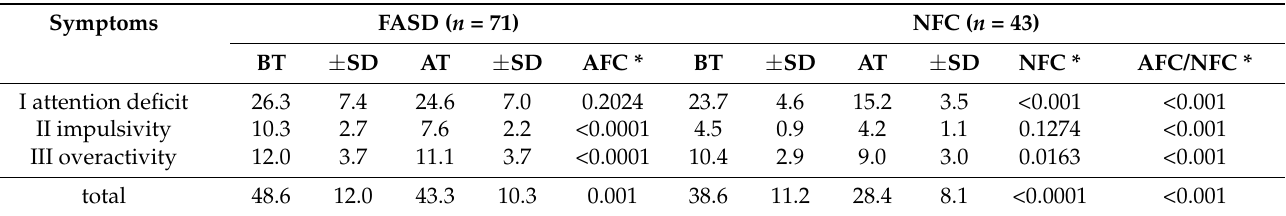
Table 3. ADHD treatment response in FASD and NFC